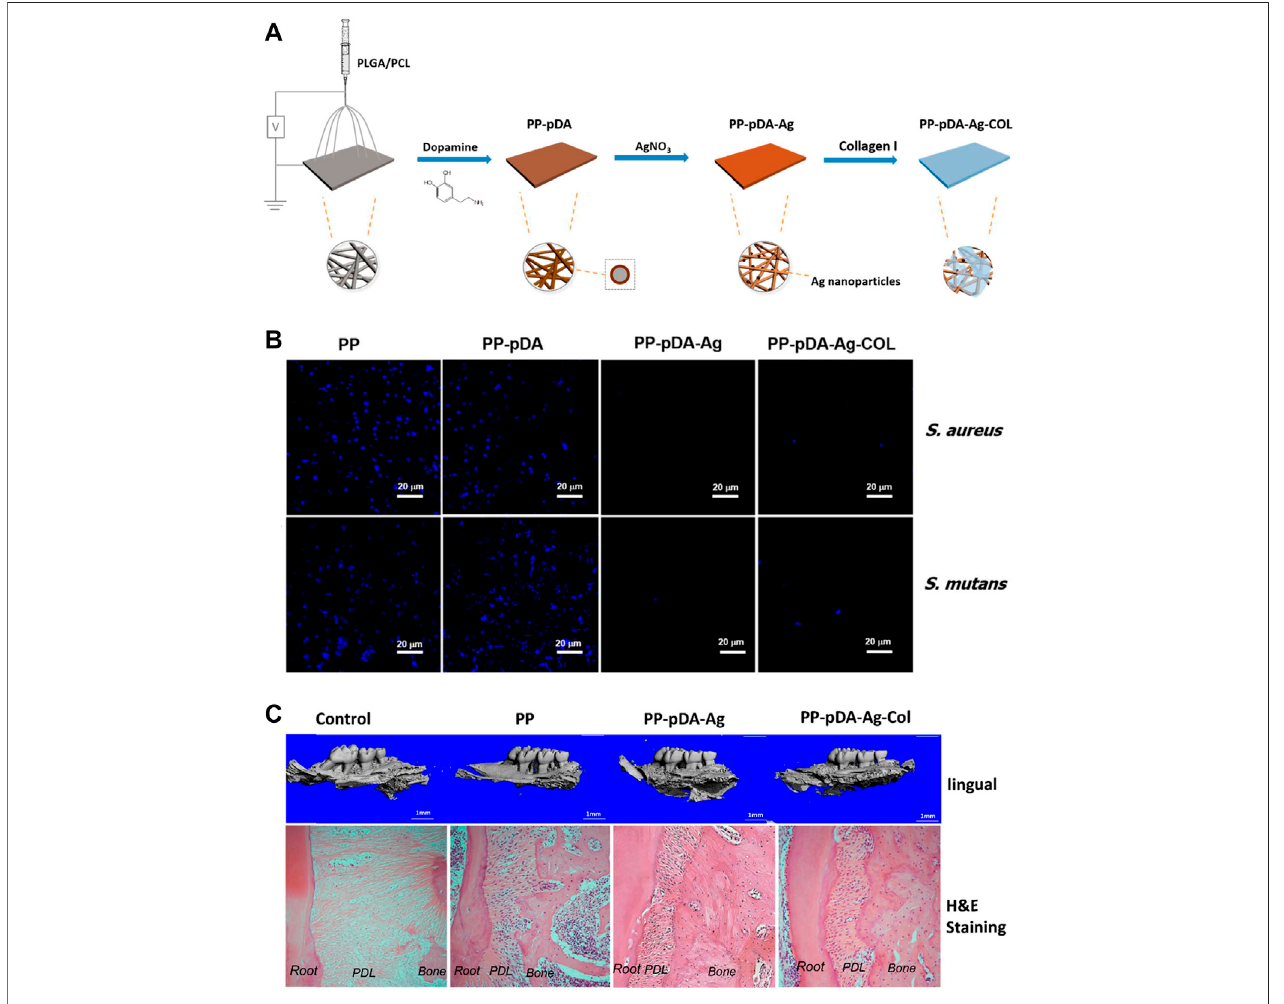
FIGURE 10 | PDA-based PP-pDA-Ag-COL scaffold for antibacterial and osteogenic activity. (A) Schematic illustration of the preparation procedure. (B) DAPI immuno fl uorescent staining of bacterial attachment. (C) 3D reconstruction and H&E staining of the regenerated periodontal tissues in periodontitis mouse model 6 weeks after implantation (Qian et al., 2019). Copyright 2019, American Chemical Society.